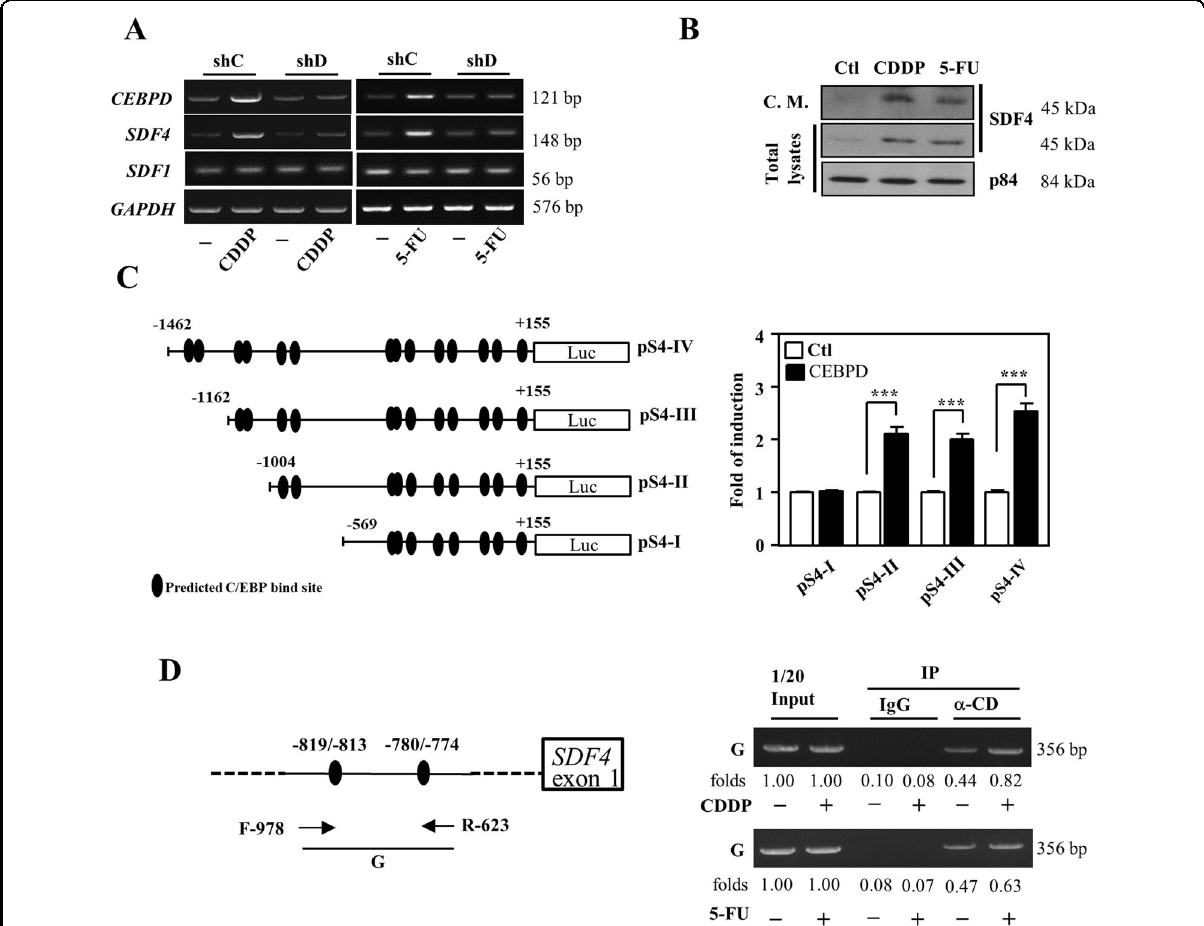
Fig. 3 SDF4 is activated upon induction of CEBPD in lung HFL1 fi broblasts. A SDF4 expression was induced following CEBPD induction by CDDP or 5-FU treatment in HFL1 cells infected with sh β -galactosidase (shC) or shCEBPD (shD) lentiviruses and treated with or without CDDP or 5-FU for 6 h. RT-PCR assays were conducted to examine the CEBPD , SDF4, SDF1 , and GAPDH transcript levels. B SDF4 expression was examined in conditioned medium (C.M.) or cell lysates from HFL1 cells after CDDP or 5-FU treatment for 6 h. p84 was used as an internal control. C CEBPD activates SDF4 reporter activity. Representation of reporter constructs (left panel). A reporter assay was conducted to assess the activity of the SDF4 reporter with or without CEBPD expression vector (right panel). D A ChIP assay was performed with the indicated antibodies. Three independent experiments were performed in triplicate. All data are expressed as the mean ± S.D. Differences between groups were analyzed with the unpaired two-tailed t -test. *** p <